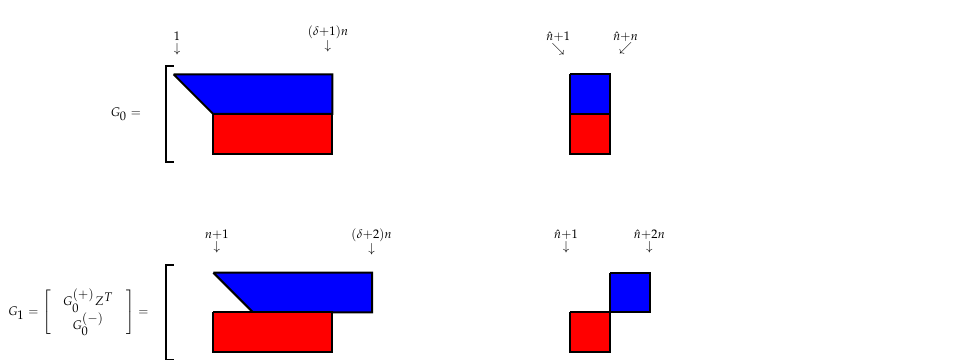
Figure 1. Modification of the sparsity pattern of the generator matrix G after the first iteration.